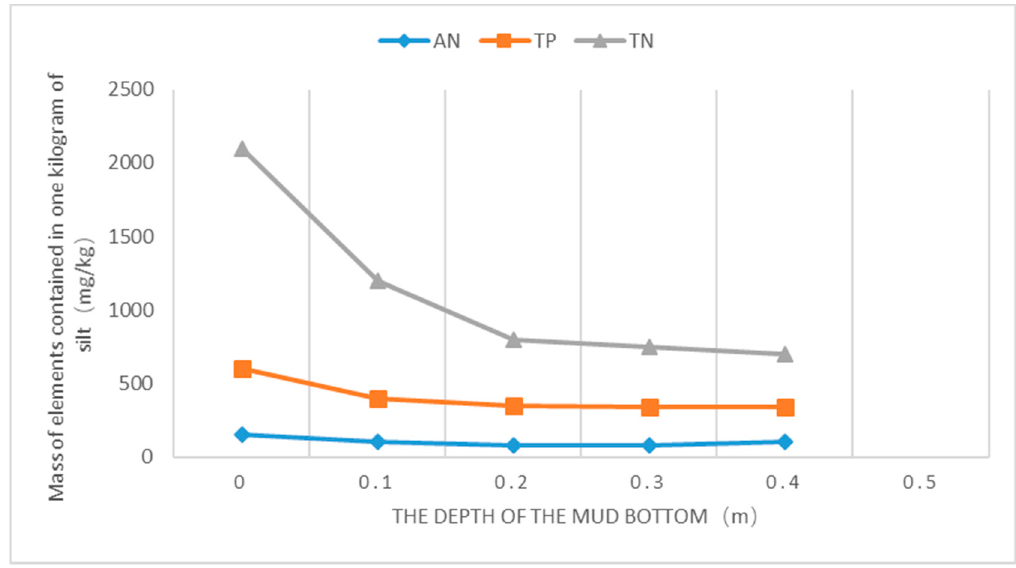
Figure 4. The relationship between the element content of the sludge bottom and the depth of the sludge bottom.